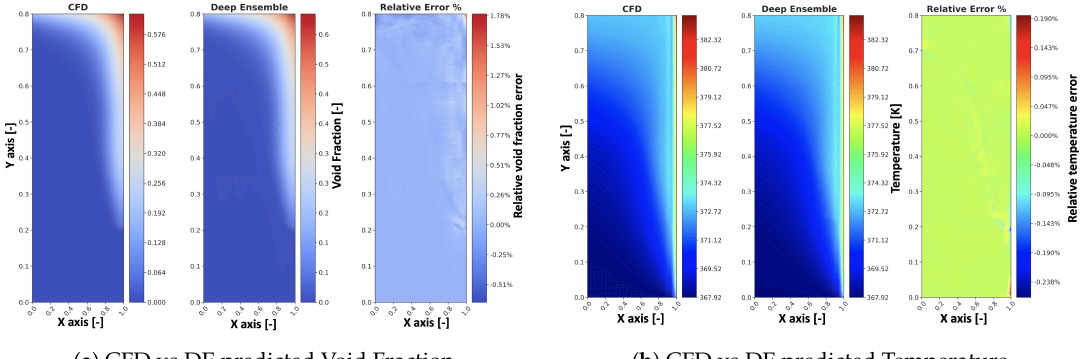
Figure A8. Extrapolation dataset: Comparison of CFD and DE model prediction for q (cid:48)(cid:48) = 40,000 W/m 2 , u = 0.2 ms − 1 . It can be again noted that the DE model outperforms the DNN model when predicting both void fraction and temperature field. The DE model has maximum relative error of 1.78% for void fraction and 0.28% for temperature field as shown in Figure